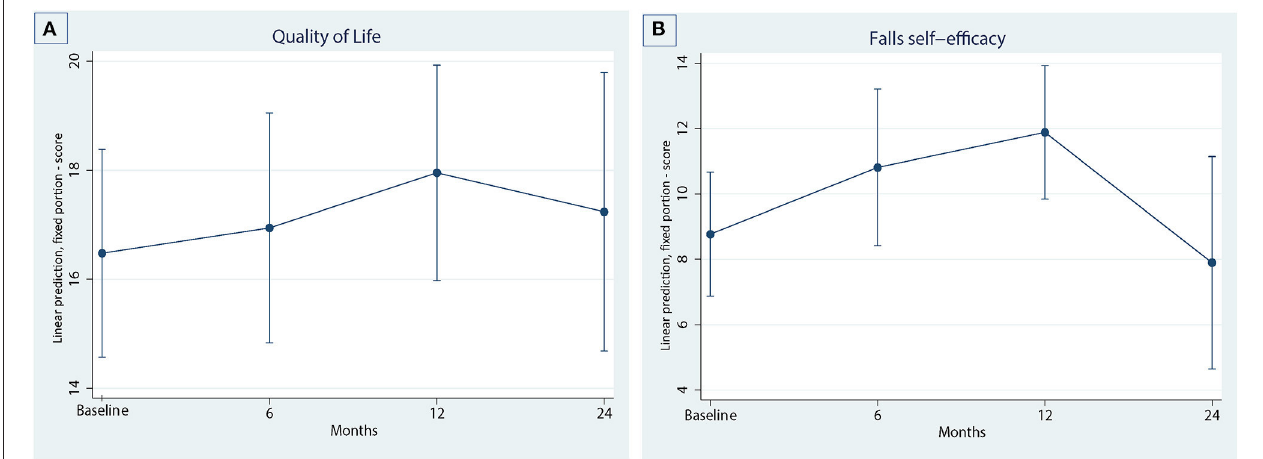
FIGURE 4 | Quality of life outcomes over four timepoints. (A) Quality of life, (B) Falls